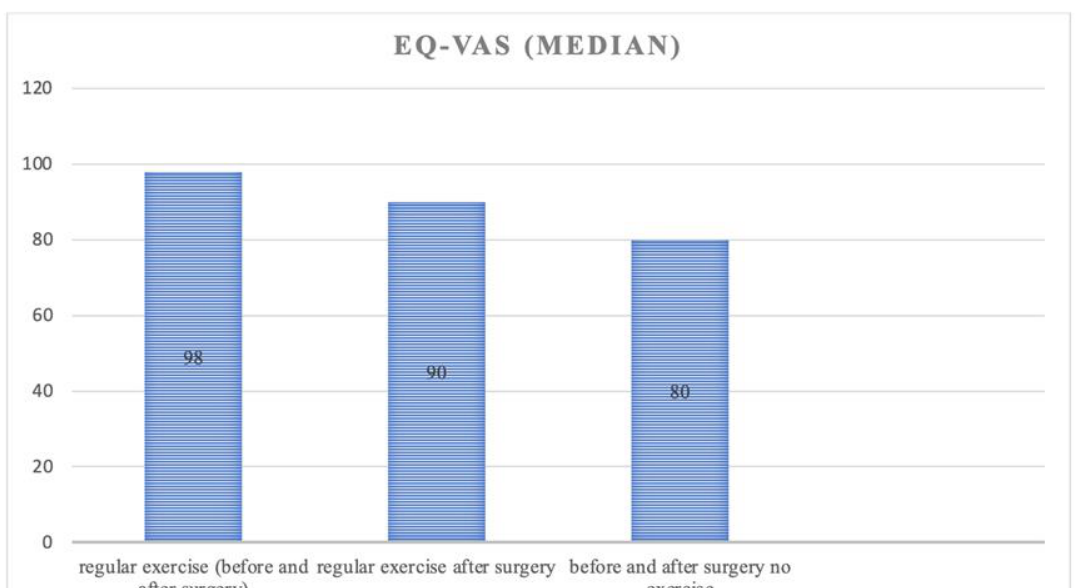
Figure 2. EQ VAS regard to exercise status.